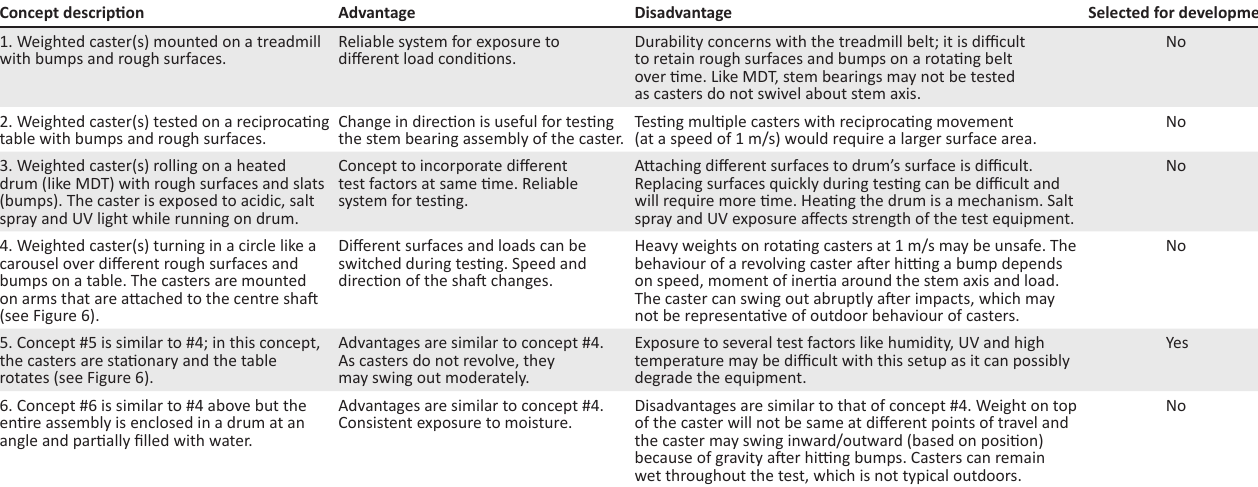
TABLE 2: Design concepts evaluated by the ISWP-SWG experts.